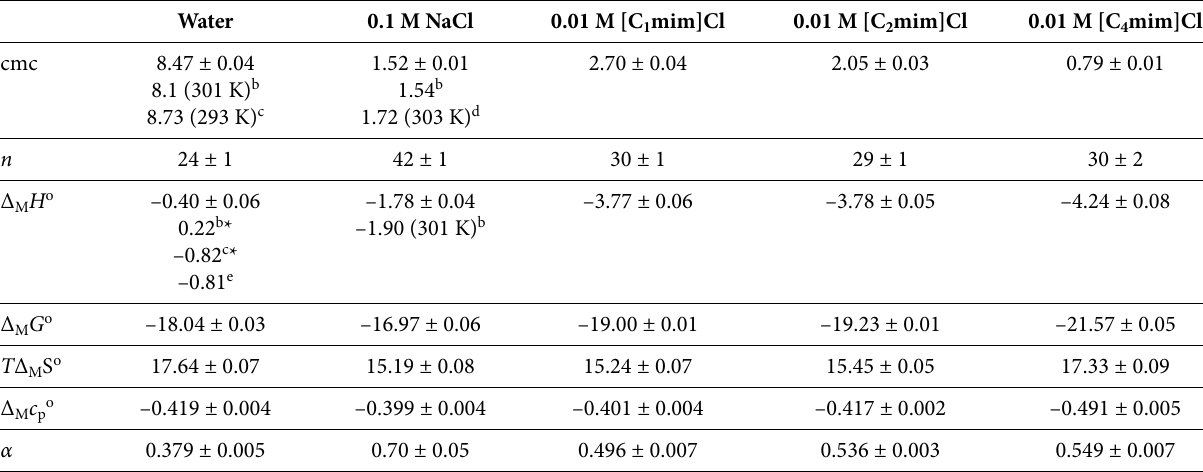
Table 1. The values of critical micelle concentration (cmc), aggregation number ( n ), enthalpy (∆ M H o ), Gibbs free energy (∆ M G o ), entropy contribu- tion ( T ∆ M S o ), heat capacity (∆ M c po ) of micellization, and a degree of micelle ionization ( α ) for SDS in all the investigated systems at 298.15 K. Where possible, the literature data are given (the numbers in parentheses denote the temperature at which the values were determined).